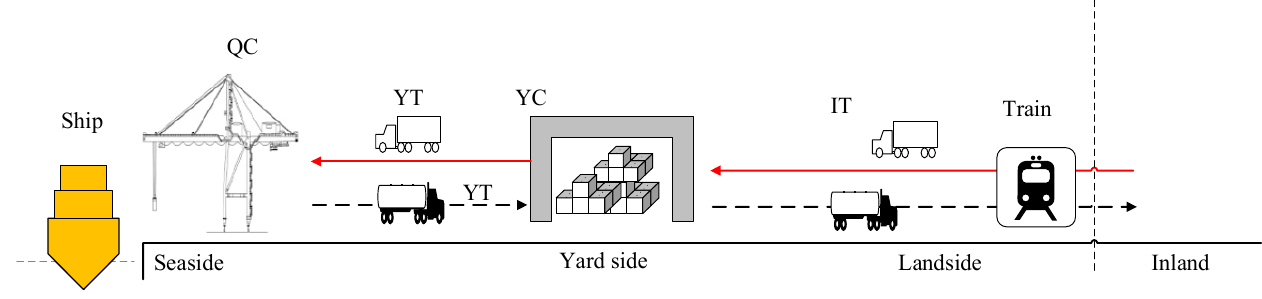
Figure 1. Operations in a container terminal.